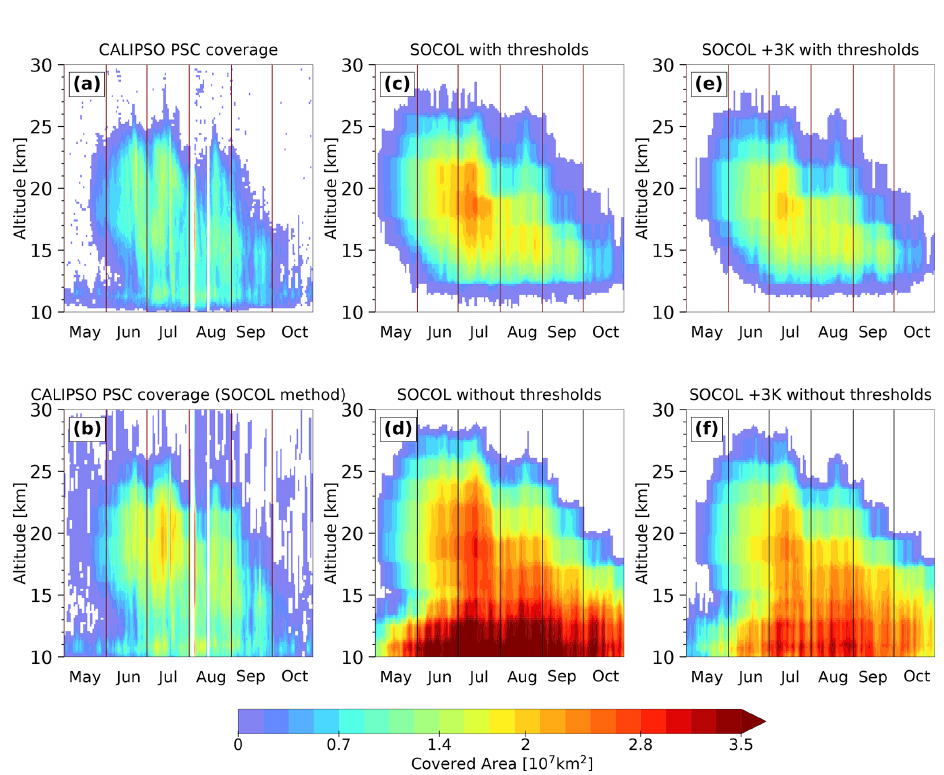
Figure A5. As Fig. 5, but for the year 2006.